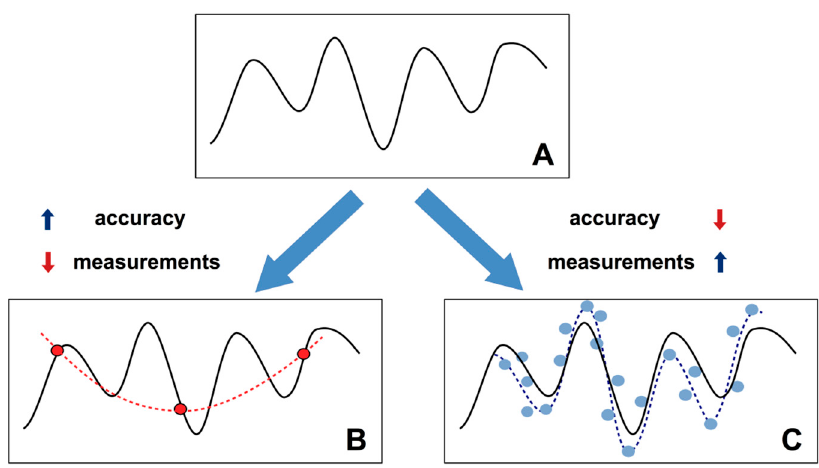
Figure 5. Example of pattern retrieval of a complex pattern ( A ) using two different approaches: Based on scientific instruments ( B ) with high accuracy but low numbers of measurements or based on citizen science approaches ( C ) with less accuracy but much larger numbers of observations. In this case, the pattern that could be retrieved with citizen science instruments (blue dotted line in ( C )) may have better results than the one retrieved with scientific instruments (red dotted line in ( B )), taking into account that regression errors from inaccurate measurements would be smaller that interpolation errors from high precision observations.